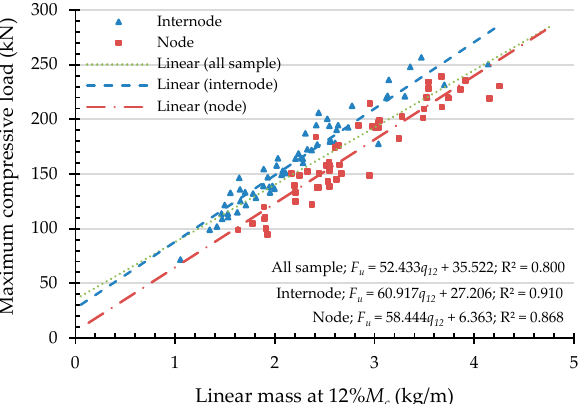
Figure 13. The simple linear regression analysis of bamboo maximum compressive load ( u F ) with external diameter as an indicating property.